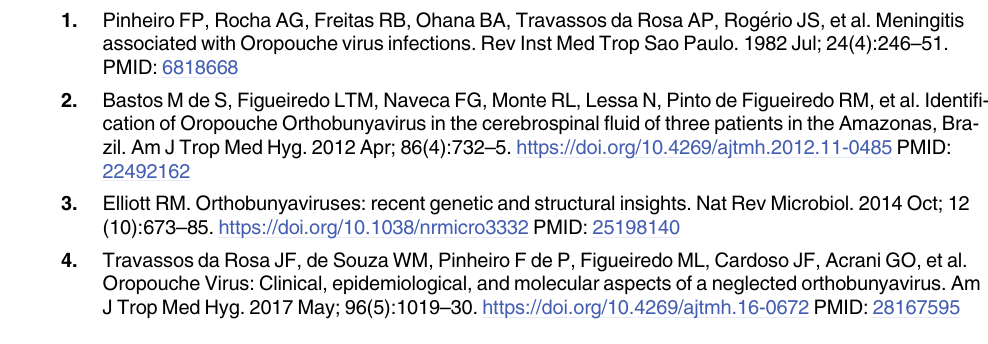
S1 Fig. The workflow that led to the identification and isolation of OROV from six febrile Ecuadorian patients. S2 Fig. Absolute quantitation was performed from a standard curve generated from a ten- fold serial dilution of a synthetic OROV RNA standard. Each data point is the mean Cq value from three separate experiments. Error bars indicate standard deviation. R 2 correlation coefficient = 0.9978. S3 Fig. OROV genome copies increase over 96 hours in Vero cells, demonstrating OROV genome replication in five independent OROV cultures from OROV-positive patient